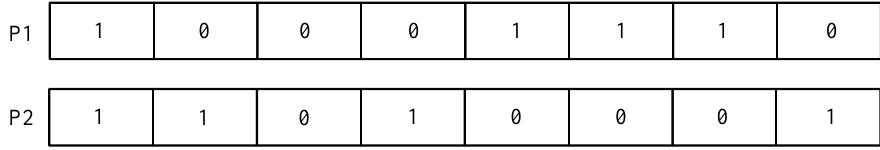
Figure 8. Nectar-collecting behavior of bees. The GABC algorithm based on the crossover operation combines the basic artificial bee colony algorithm with the crossover operation in the genetic algorithm. In the crossover operation, the two selected individuals are taken as the parent individuals, and the part of the code values of the two is exchanged by bit. The experiment has two eight-bit individuals, P1 and P2, as shown in Figure 9.